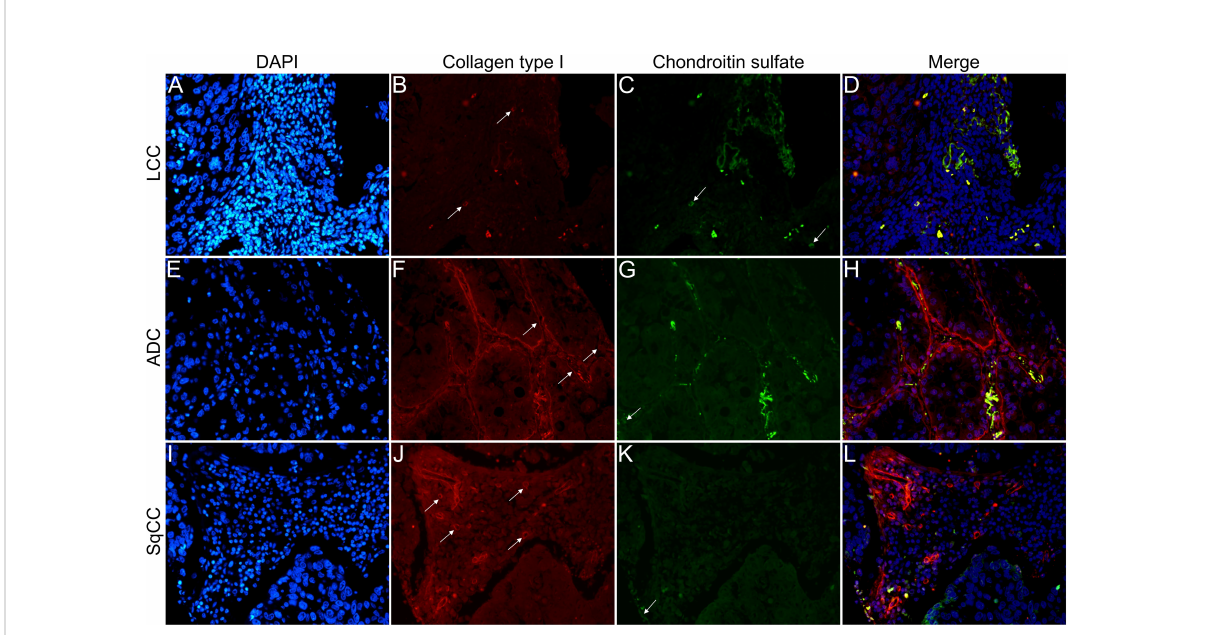
FIGURE 6 Co-analysis of immuno fl uorescence of chondroitin sulfate (green; C , G , K ) and collagen type I (red; B , F , J ) in three different histological subtypes of non-small cell lung carcinoma (N=120). The stained nuclei are represented in blue (DAPI; A , E , I ). Images D , H , L represent the merge of the same fi eld of these three stains. White arrows indicate positive expression of the markers. Original magni fi cation: 40x. LCC, large cell carcinoma; ADC, lung adenocarcinoma; SqCC: lung squamous cell